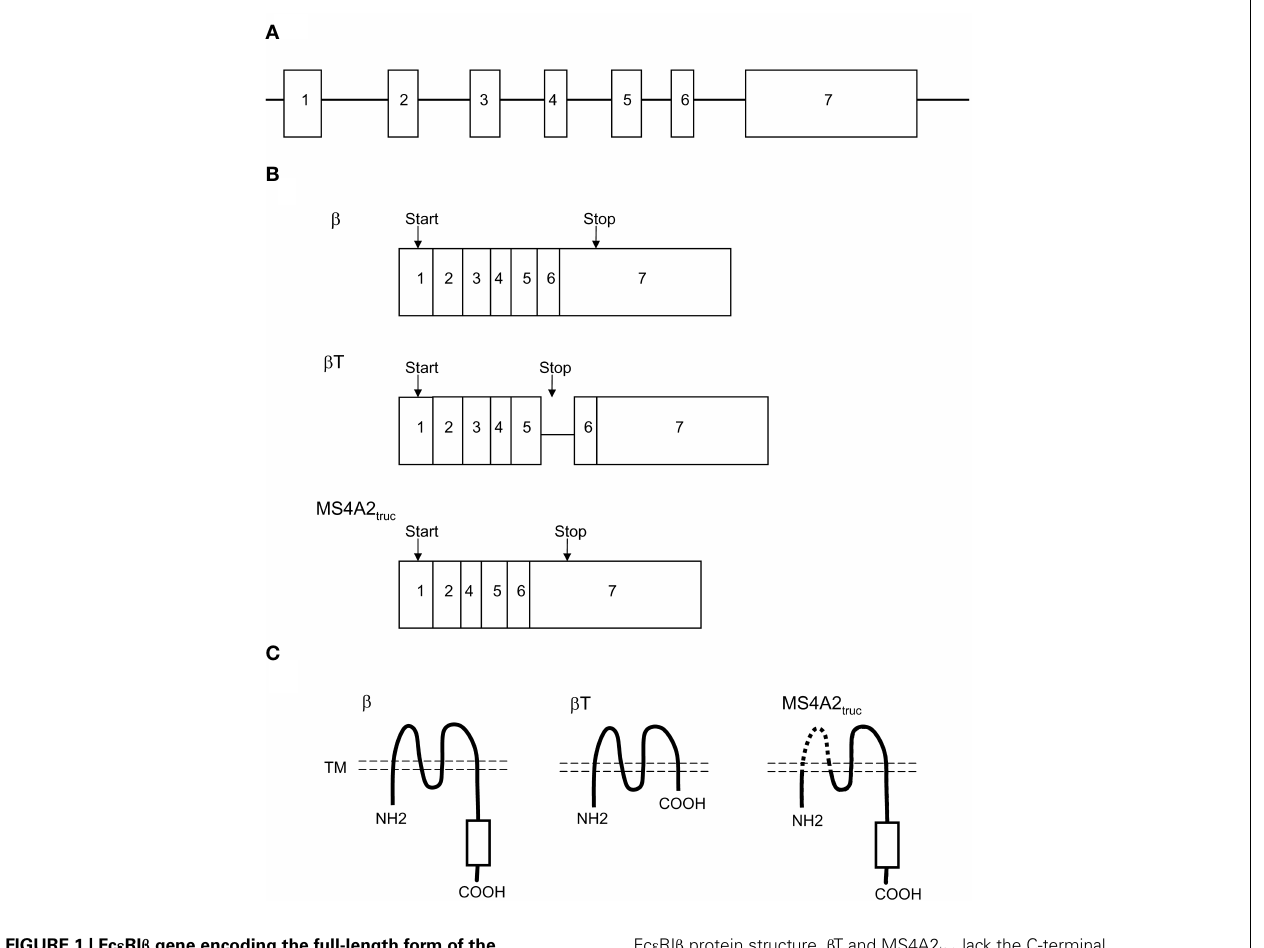
Fc ε RI β protein structure. β T and MS4A2 truc lack the C-terminal cytoplasmic region and transmembrane (TM) region (dashed line),